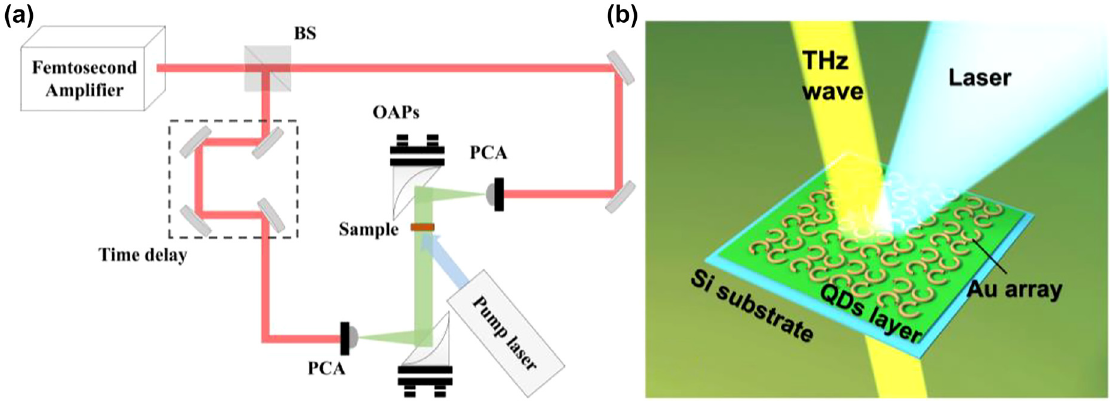
Figure 2: Experimental setup. (a) The schematic diagram of experimental setup of THz-TDS combined with a modulating laser. (b) Designed THz modulator. PCA: photoconductive antenna; OAP: off-axis